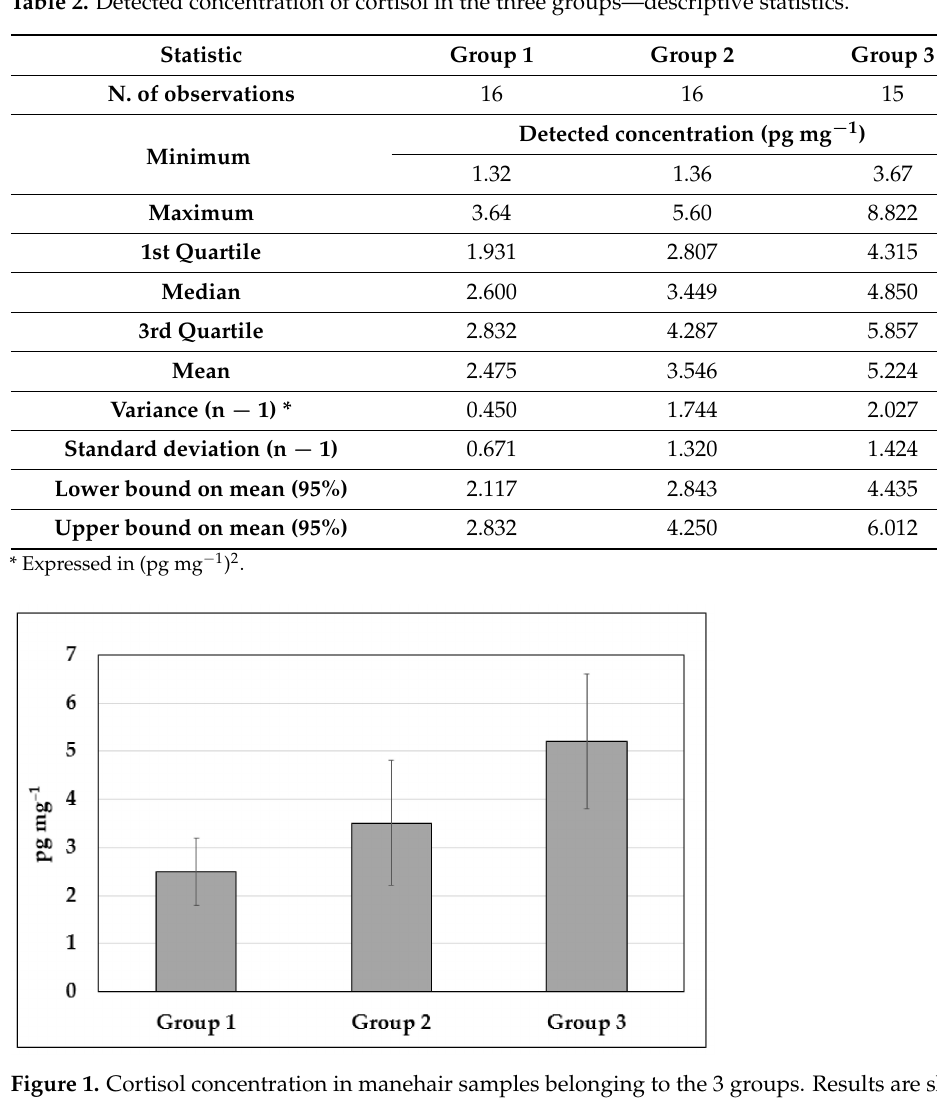
Table 2. Detected concentration of cortisol in the three groups—descriptive statistics.